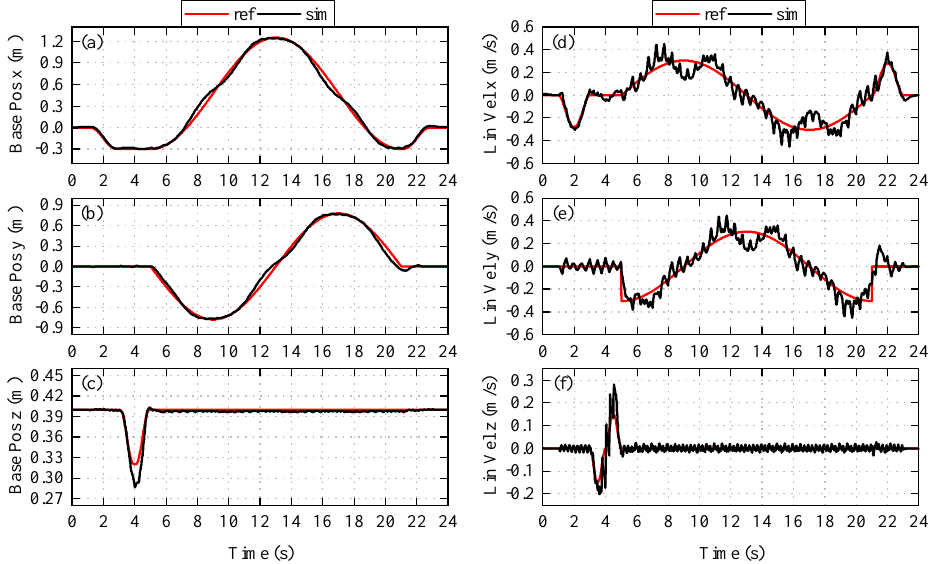
Figure 4. Base position and linear velocity. Graphs ( a – c ) are position tracking in the x-, y-, and z-direction. Graphs ( d – f ) are linear velocity tracking and these velocities are expressed in the world